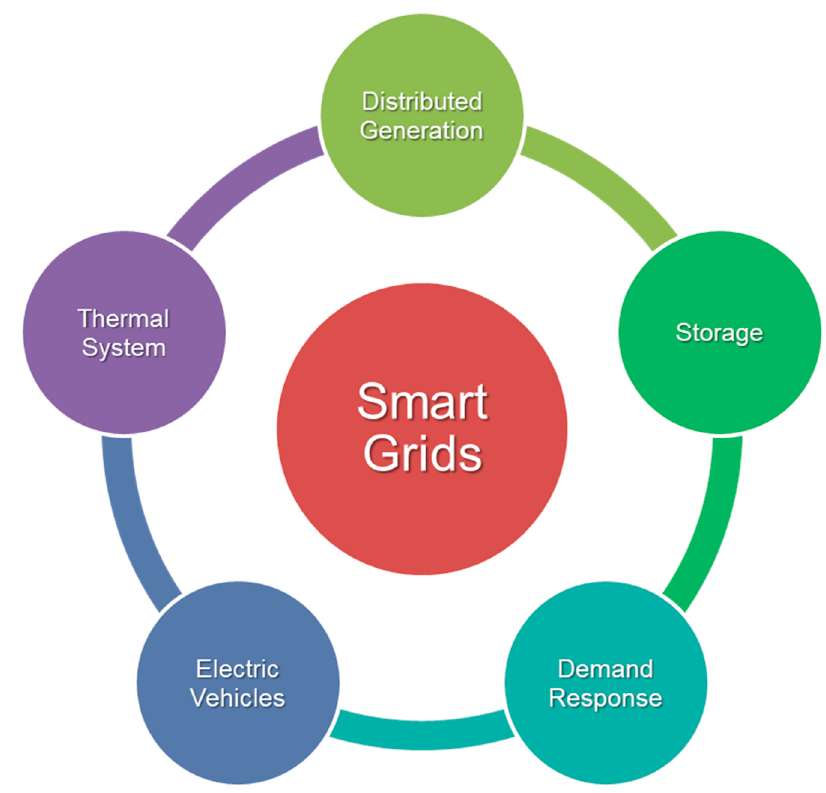
Figure 5. Main technologies related to smart grids.